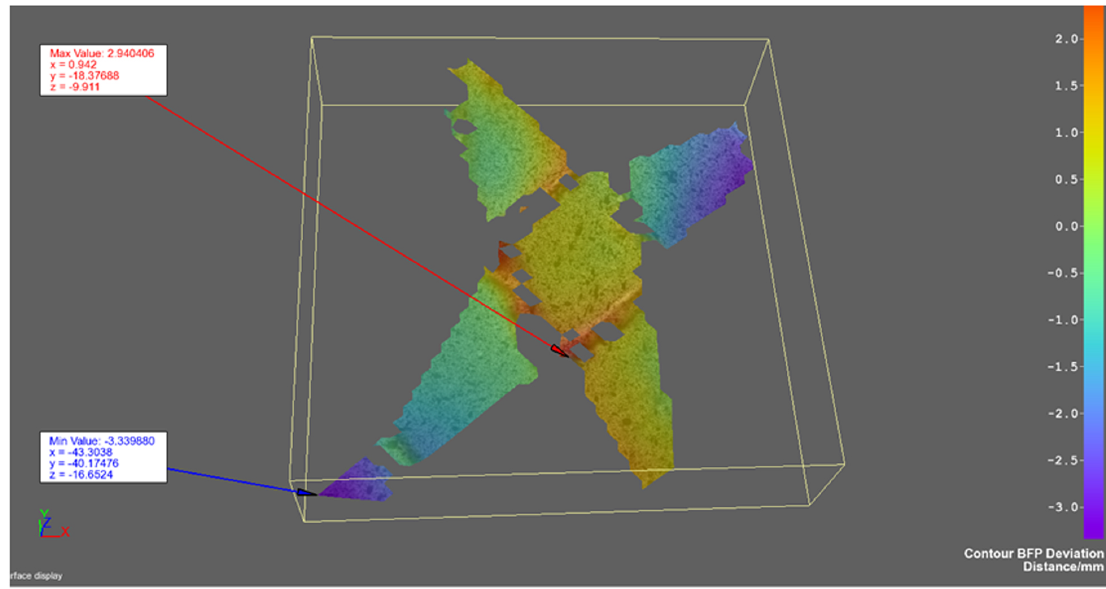
Figure 14: Strain Diagram for measurements 2. The minimum and the maximum values are reported